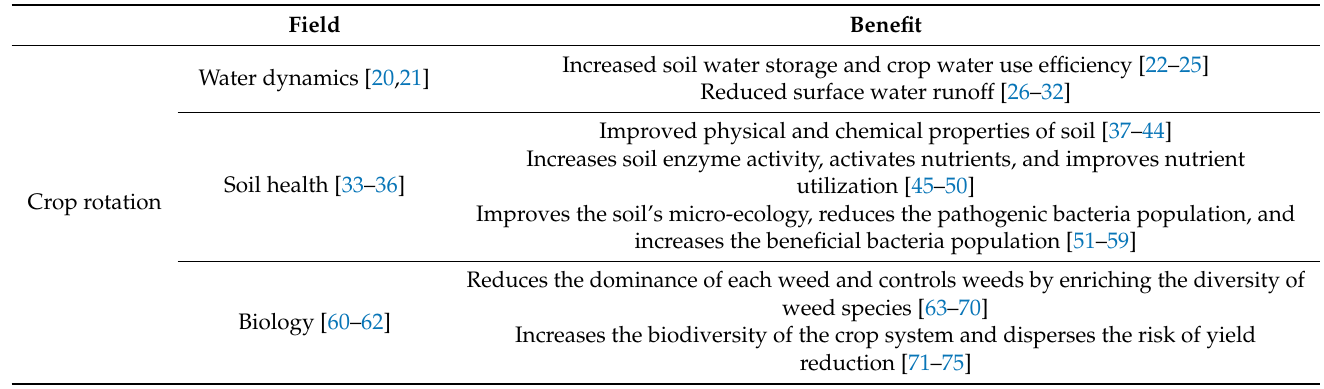
Table 1. Benefits of crop